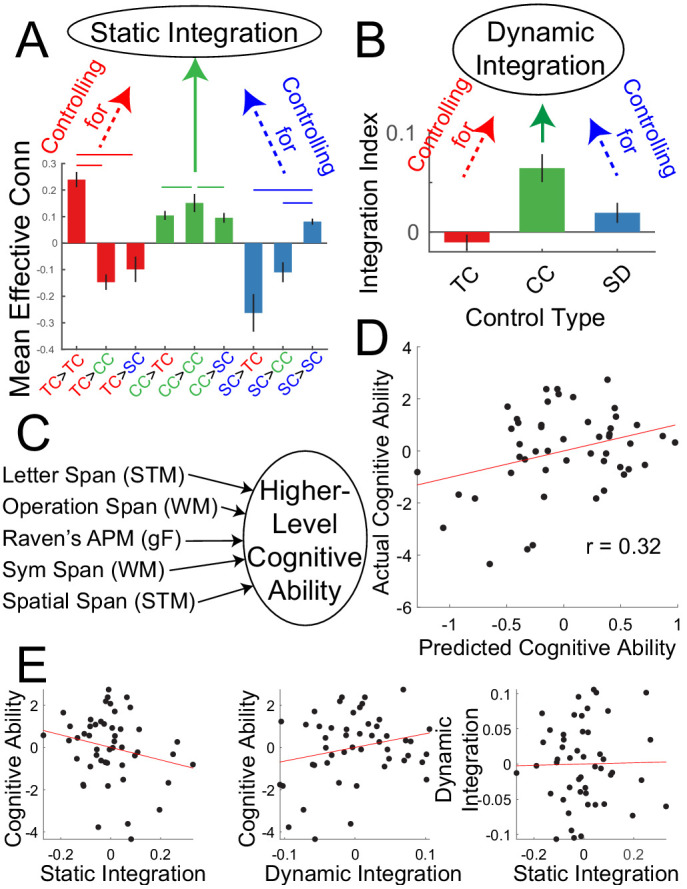
Integration predicts higher level cognitive ability.(A) Static integration was computed by contrasting between minus within-network effective connectivity of the contextual control network while controlling for (regressing out) the same contrast of the temporal control network and sensory-motor control network and individual differences in head motion. (B) Dynamic integration was based upon the integration index of the contextual control PPI’s while controlling for (regressing out) the integration indices of the temporal control and stimulus domain PPI’s and individual differences in head motion. (C) Higher level cognitive ability was computed as the first principle component of a battery of cognitive tests measuring capacity. (D) Cross-validated ridge regression was used to predict cognitive capacity based upon static and dynamic integration. The scatterplot depicts correlations between the predicted cognitive ability and actual cognitive ability. (E) Correlations among static integration, dynamic integration, and cognitive ability.